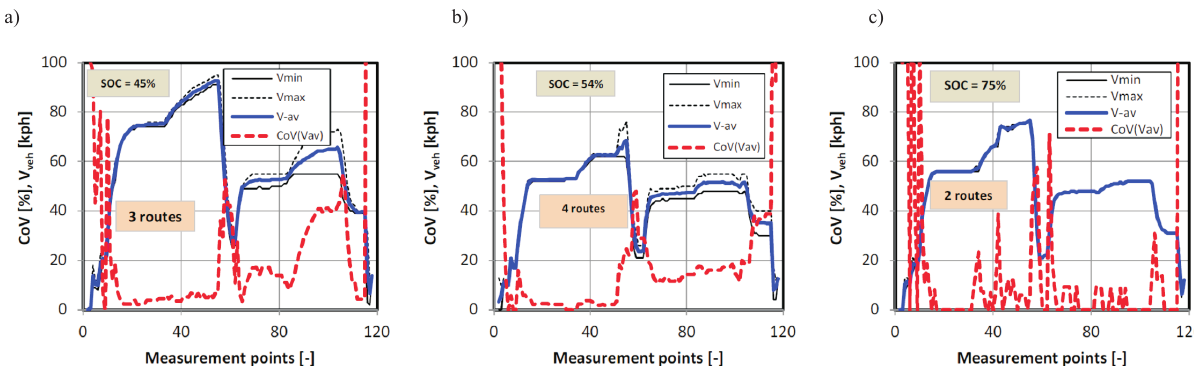
Fig. 7. Conditions of the vehicle driving speed repeatability with hybrid drive system and the variations of distribution values at varying battery charge levels: a) 45%, b), approx. 54%, c) approximately 75% Rys. 7. Warunki powtarzalności prędkości jazdy pojazdu z układem napędu hybrydowego oraz wartości rozrzutów przy różnym stopniu naładowania akumulatorów: a) 45%, b) około 54%, c)